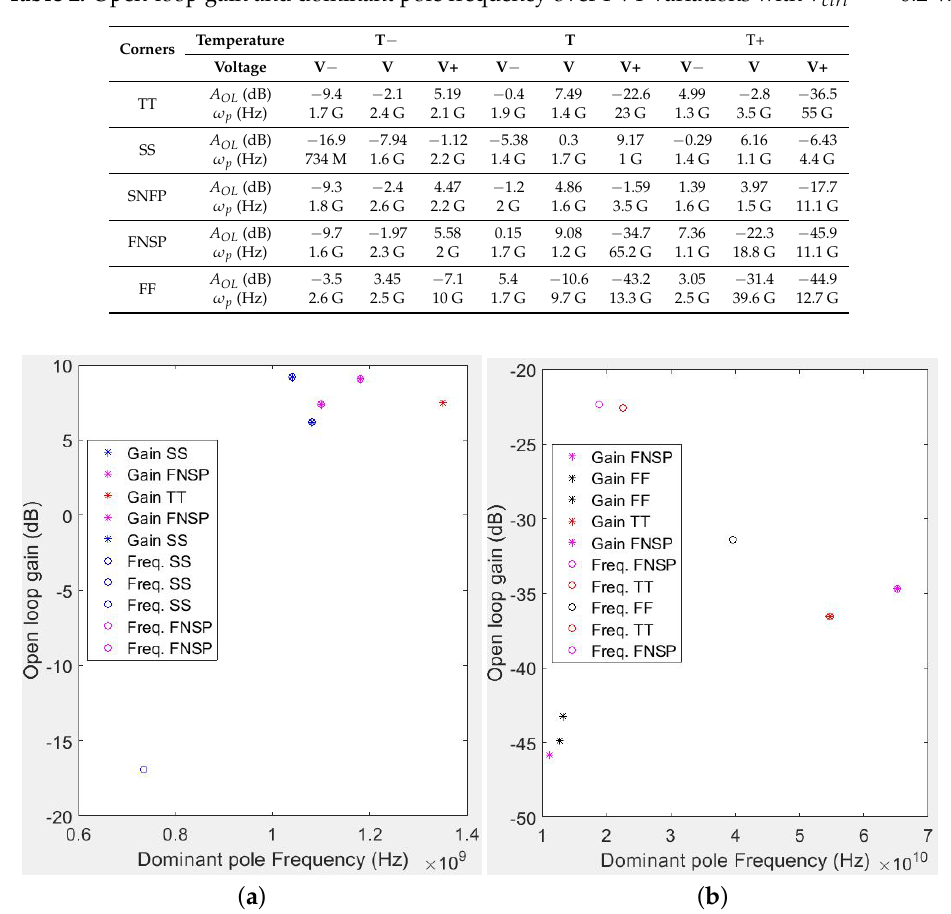
Figure 7. ( a ) Higher and ( b ) lower gains and dominant pole frequencies, for the CMOS differential stage with active load and V ctrl = − 0.2 V.